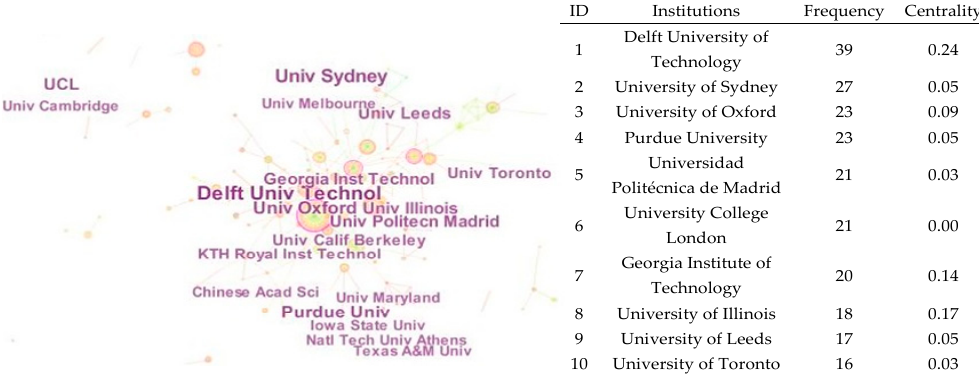
Figure 5. Institution collaboration network.